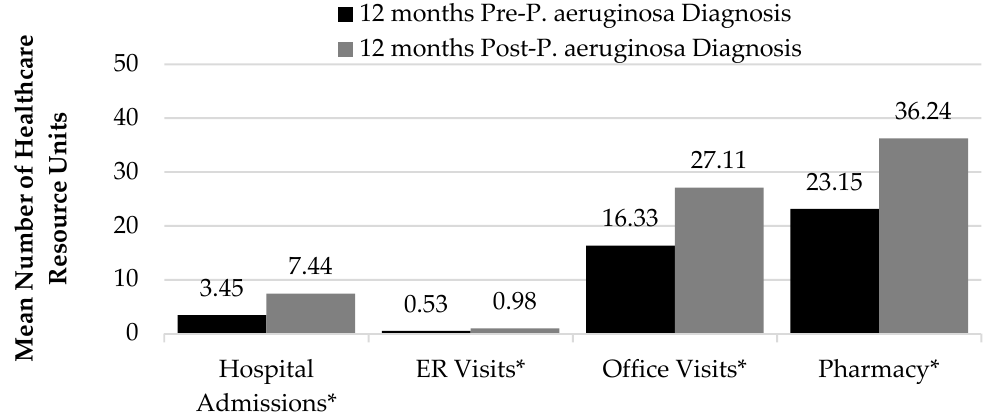
Figure 2. Healthcare utilization (pre ‐ vs. post ‐ P. Aeruginosa; *p<0.0001 ).